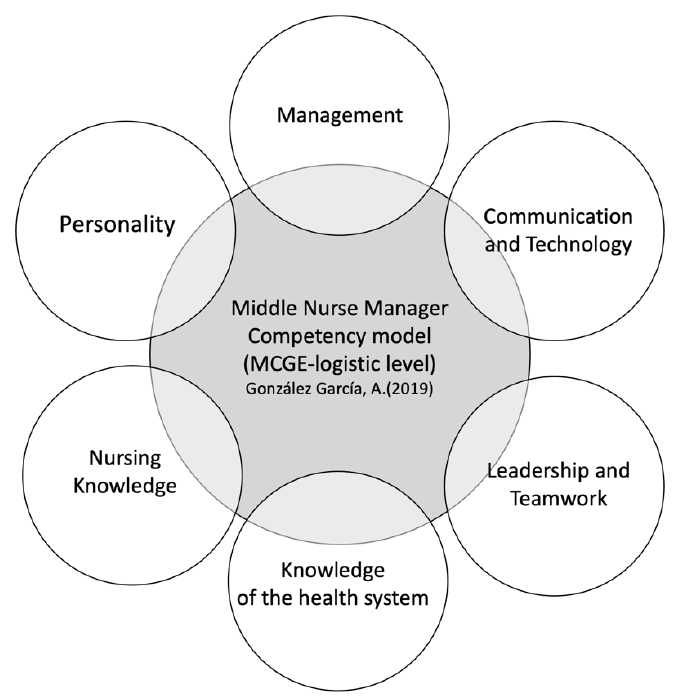
Figure 2. Dimensions of the middle nurse manager executive competency model. Source: own elaboration.